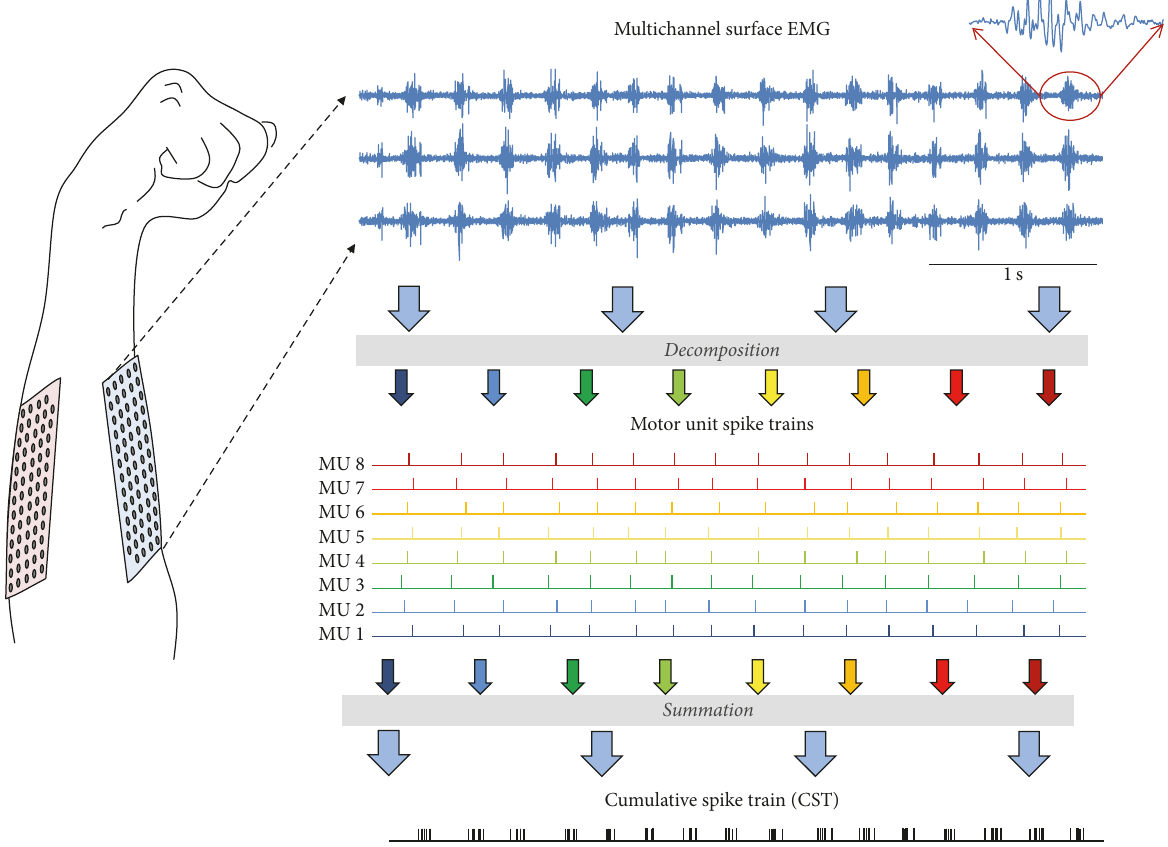
Figure 2: Experimental methods and estimation of the neural drive to muscle. Left: schematic of two 64-channel electrode arrays placed on the wrist flexors and extensors. Right: multichannel surface EMG in pathological tremor (upper panel) and its decomposition into constituent motor unit spike trains (lower panel). Decomposition allows for the identification of motor unit firing patterns and thus of the neural drive to muscles. Each vertical line in the lower right panel denotes an individual motor unit firing, whereas different motor units are depicted by different colors. Motor unit firing patterns are highly synchronized and have been identified using the Convolution Kernel Compensation (CKC) method [24]. Summed MU spike trains form cumulative spike train (CST; bottom-most panel).